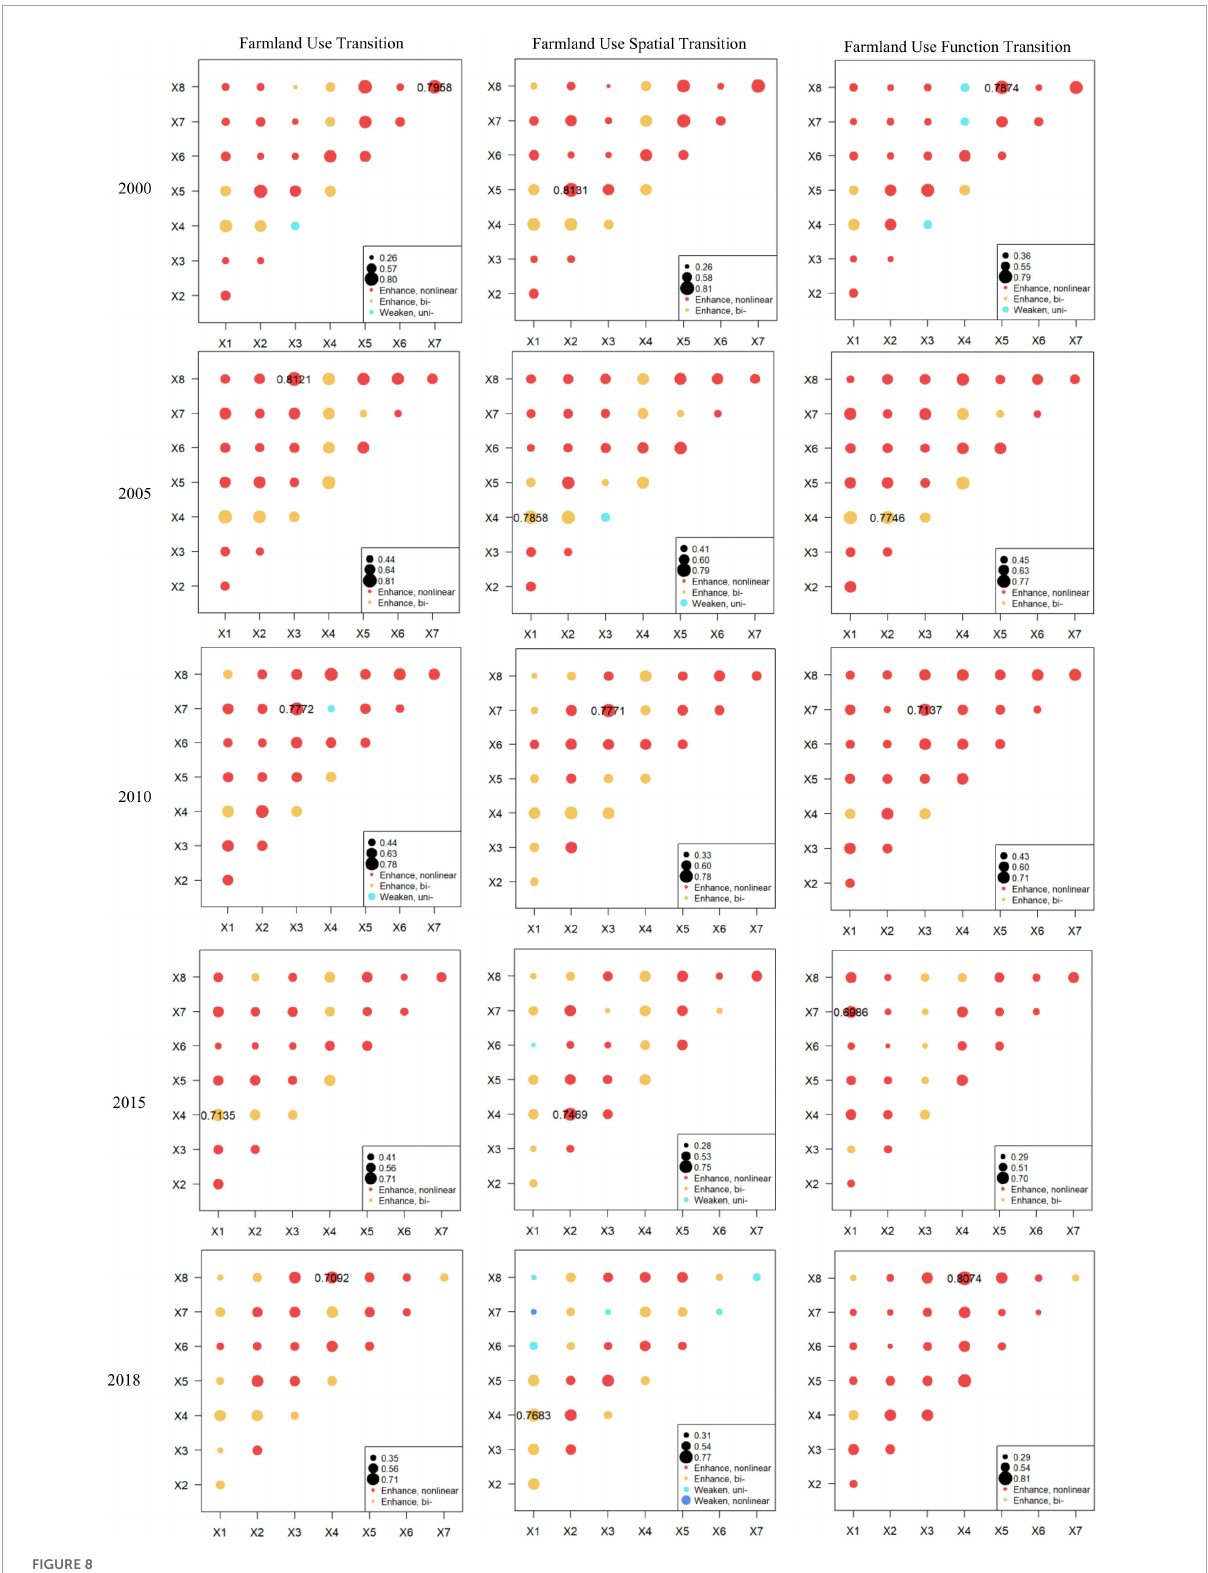
FIGURE8 Interaction detection